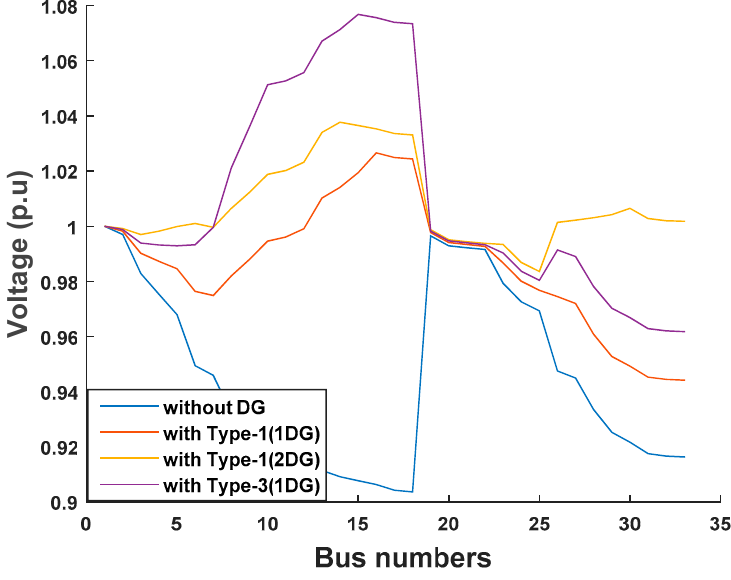
Figure 11. Voltage profile for 33 bus with Type-1 (1 DG and 2 DG) and Type-3 (1 DG) for 2nd objective function.